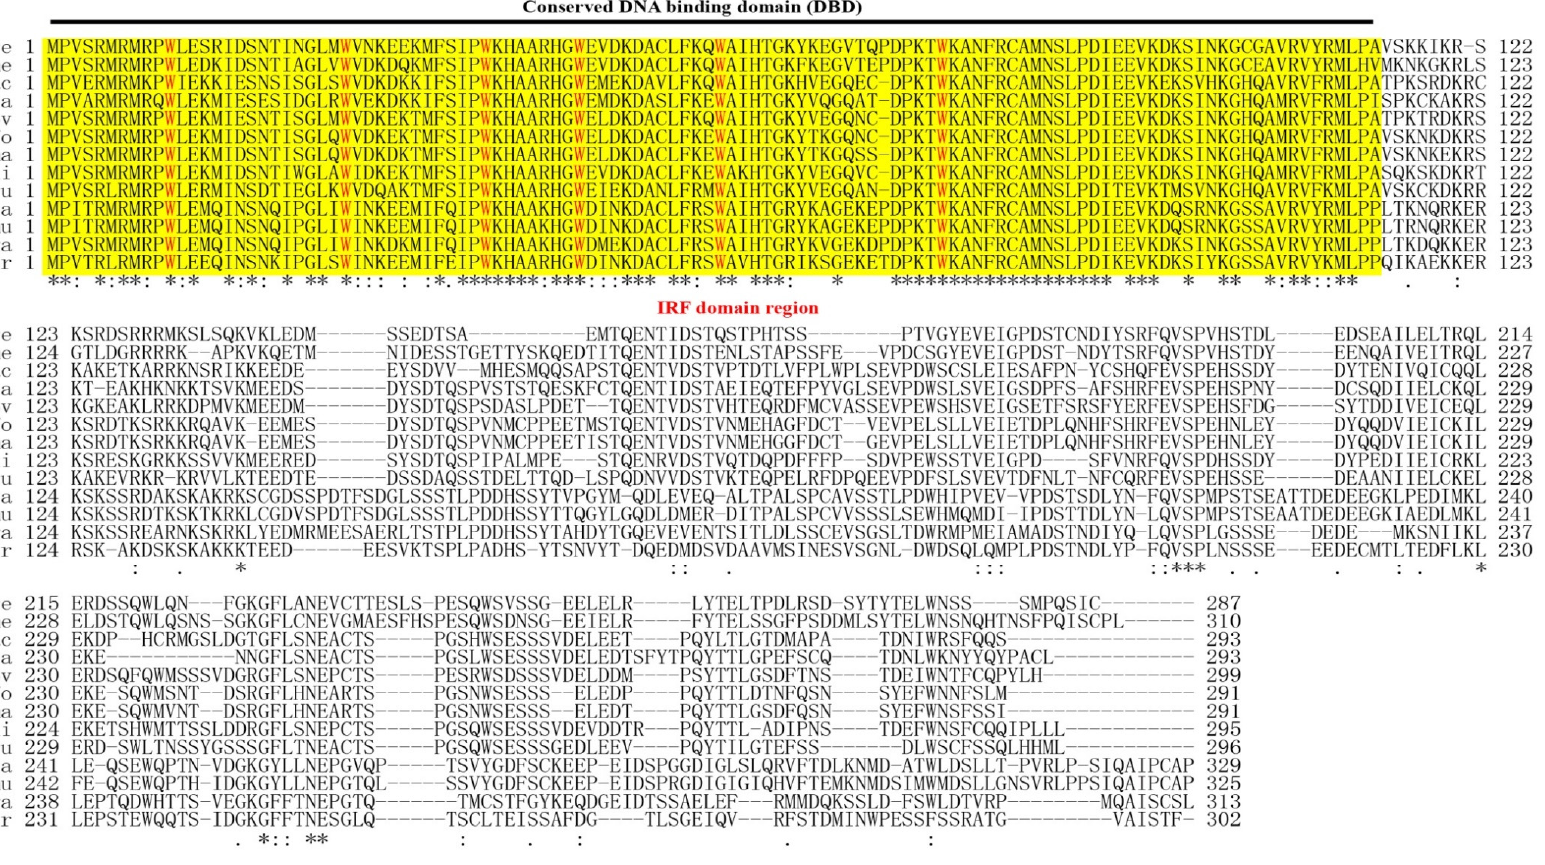
Figure 1. Amino-acid sequences of interferon (IFN) regulatory factor 1 (IRF1) homologs in vertebrates. The overline indicates the conserved DNA-binding domain (DBD) signature (amino acids (aa) 1–113), which contains six conserved tryptophan residues. It is also called the IRF domain (yellow underlay). Identical (asterisks) and similar (: or ∙ ) residues identified by the CLUSTAL W program are indicated. The Latin abbreviation and accession numbers are listed in Table S1 (Supplementary Materials).